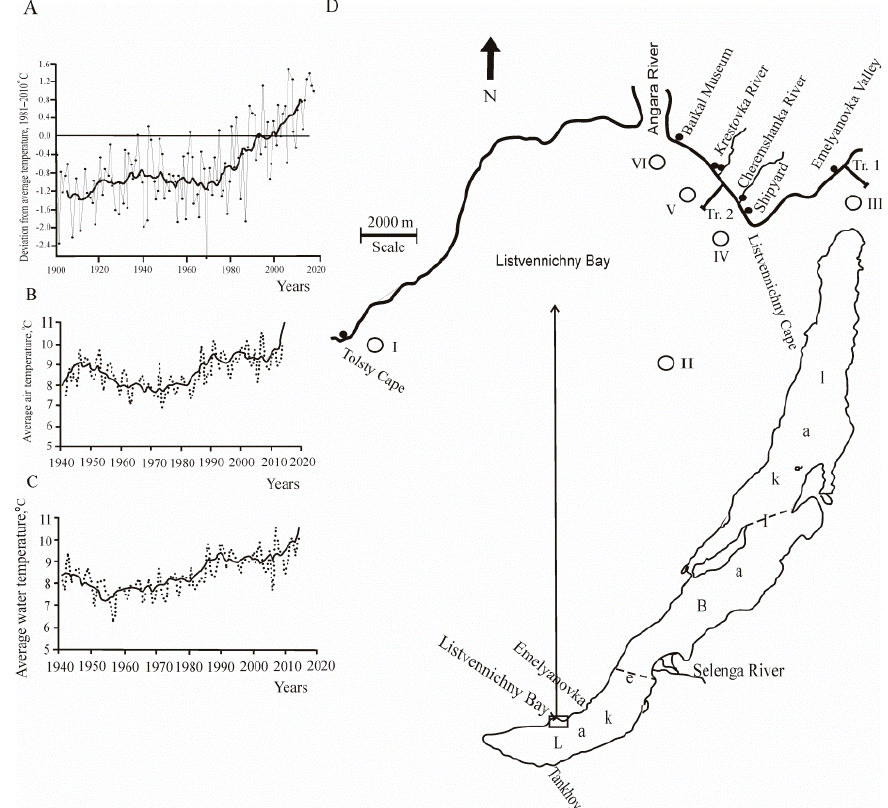
Figure 1. Ambient temperature trends for the territory of Russia and the Baikal region, and sampling map of Lake Baikal: ( A ) Averaged anomalies of the mean annual temperature at the earth’s surface for the territory of Russia from 1901 to 2018 (according to the Y.A. Izrael Institute for Global Climate and Ecology; the data is free available from http://climatechange.igce.ru (accessed on 6 September 2021)). ( B ) Averaged air temperatures in the Baikal region. ( C ) Averaged surface water temperatures of Lake Baikal (according to [15]). ( D ) Sampling station. Plankton sampling at two sites at depths from 0 to 15 m of the water layer. The background Site 1 included stations that are outside the zone with the impact of human activity: I—opposite Tolsty Cape in the open part of the southern basin 14 km in a southwestern direction from Listvennichny Cape (N 51 ◦ 47 (cid:48) 309; E 104 ◦ 36 (cid:48) 736); II—open part of the southern basin 7 km off the shore in direction to Listvennichny Cape-Tankhoy settlement (N 51 ◦ 48 (cid:48) 718; E 104 ◦ 53 (cid:48) 126); III—opposite Emelyanovka Valley in northwestern direction 5 km off Listvennichny Cape (N 51 ◦ 51 (cid:48) 529; E 104 ◦ 56 (cid:48) 463). Site 2 with anthropogenic impact included stations located in the coastal zone of Listvennichny Bay adjacent to the Listvyanka settlement at a distance of 50–100 m off the shore opposite the shipyard (IV) (N 51 ◦ 50 (cid:48) 479; E 104 ◦ 52 (cid:48) 772), Krestovka Valley (V) (N 51 ◦ 51 (cid:48) 236; E 104 ◦ 51 (cid:48) 595), and Baikal Museum (VI) (N 51 ◦ 52 (cid:48) 021; E 104 ◦ 49 (cid:48) 683). Benthos samples were collected from stones at the transects from the 0 to 5 m depth range opposite Emelyanovka Valley (Tr. 1) (N 51 ◦ 51 (cid:48) 529; E 104 ◦ 56 (cid:48) 463) and Krestovka Valley (Tr. 2) (N 51 ◦ 51 (cid:48) 236; E 104 ◦ 51 (cid:48) 595). Light circles are plankton sampling stations and water sampling stations for hydrochemical analysis in the Baikal coastal zone; dark circles—water sampling stations for nutrient determination in rivers and groundwater on the beach; the dotted line indicates the boundaries between the southern, central, and northern basins of Lake